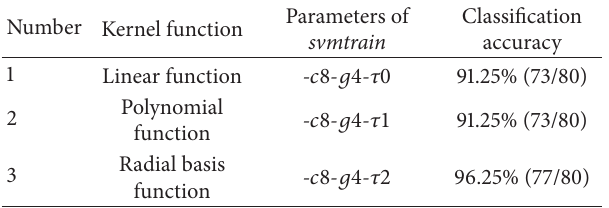
Table 5: Classification accuracy using different SVM kernel func-